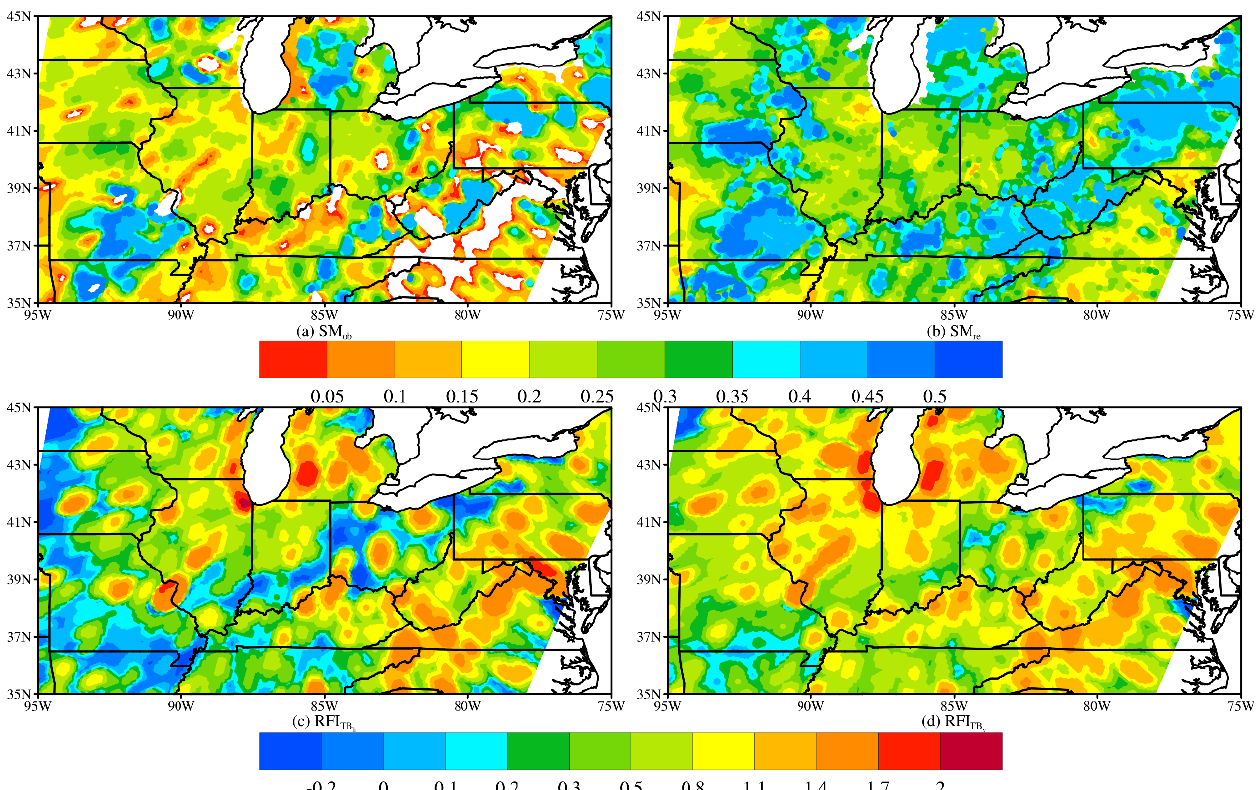
Figure 5. Spatial distribution of soil moisture retrieved from 6 GHz brightness temperatures before ( a ) and after restoration ( b ) and the spatial distribution of RFI in the horizontal channel ( c ) and vertical channel ( d ) in the region on 27 October 2016.